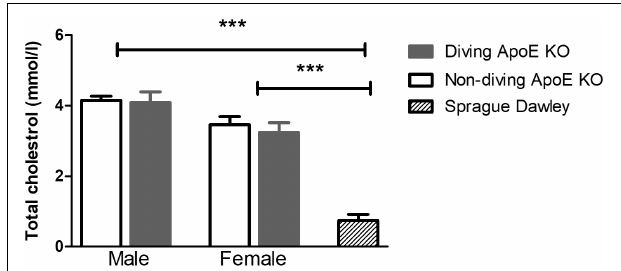
FIGURE 2 | The total cholesterol in blood plasma from ApoE KO male and female rats was significantly higher than in Sprague Dawley rats that form a genetic background for ApoE KO rats, ∗∗∗ P < 0.001, ANOVA, n =